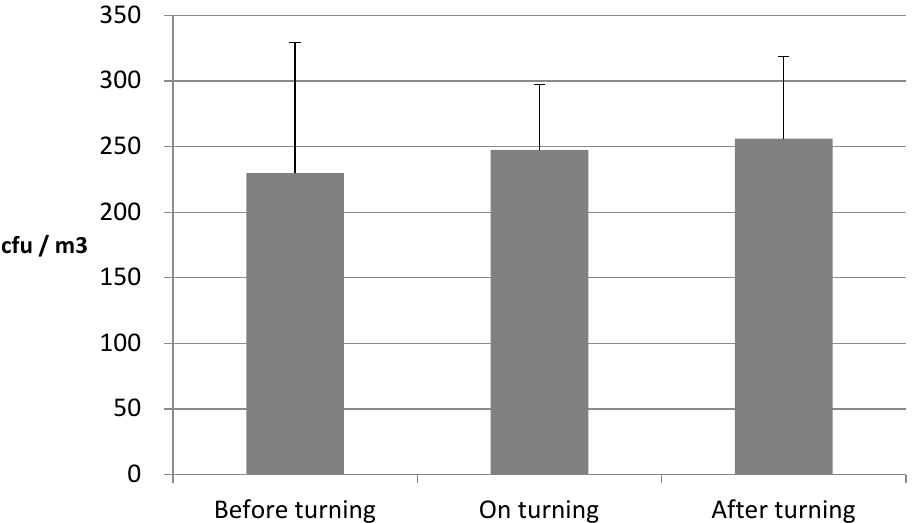
Figure 2. Mean level of airborne fungi in livestock manure composting plants according to agitation time of compost pile.